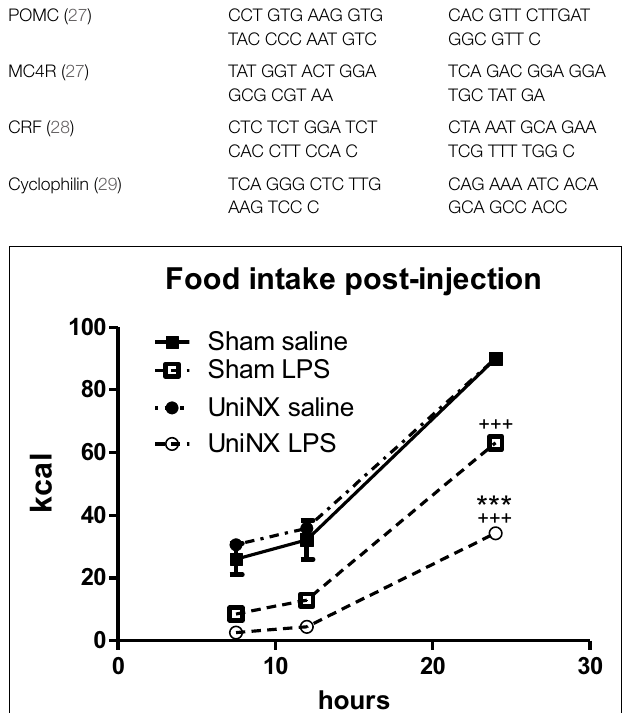
FIGURE 2 | Cumulative food intake over 24h for Sham and UniNX rats treated with i.p. saline or LPS (100 μμμ g/kg body weight) . Values are means (cid:6) SE; n = 8/group. +++ p < 0.001 corresponds to Sham vs. Sham-LPS or UniNX vs. UniNX-LPS. *** p < 0.001 corresponds to